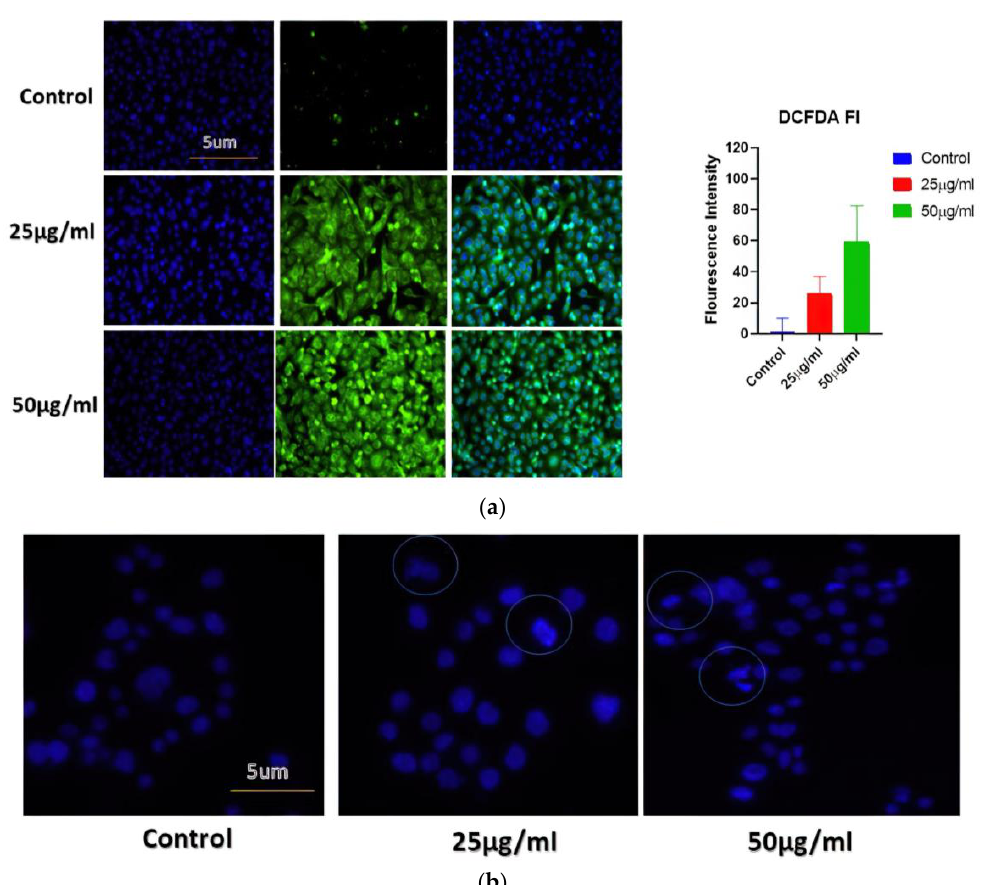
Figure 5. ( a ) Determination of cellular ROS generation in different cancer cell lines when exposed to increasing concentrations of BAgNPs by fluorescence microscopic analysis. Untreated cells were used as a control. ( b ) The apoptosis analysis in A549 cells using fluorescence microscopy. Here, cells were treated with BAgNPs and stained with Hoechst 322 dye and observed under the microscope.